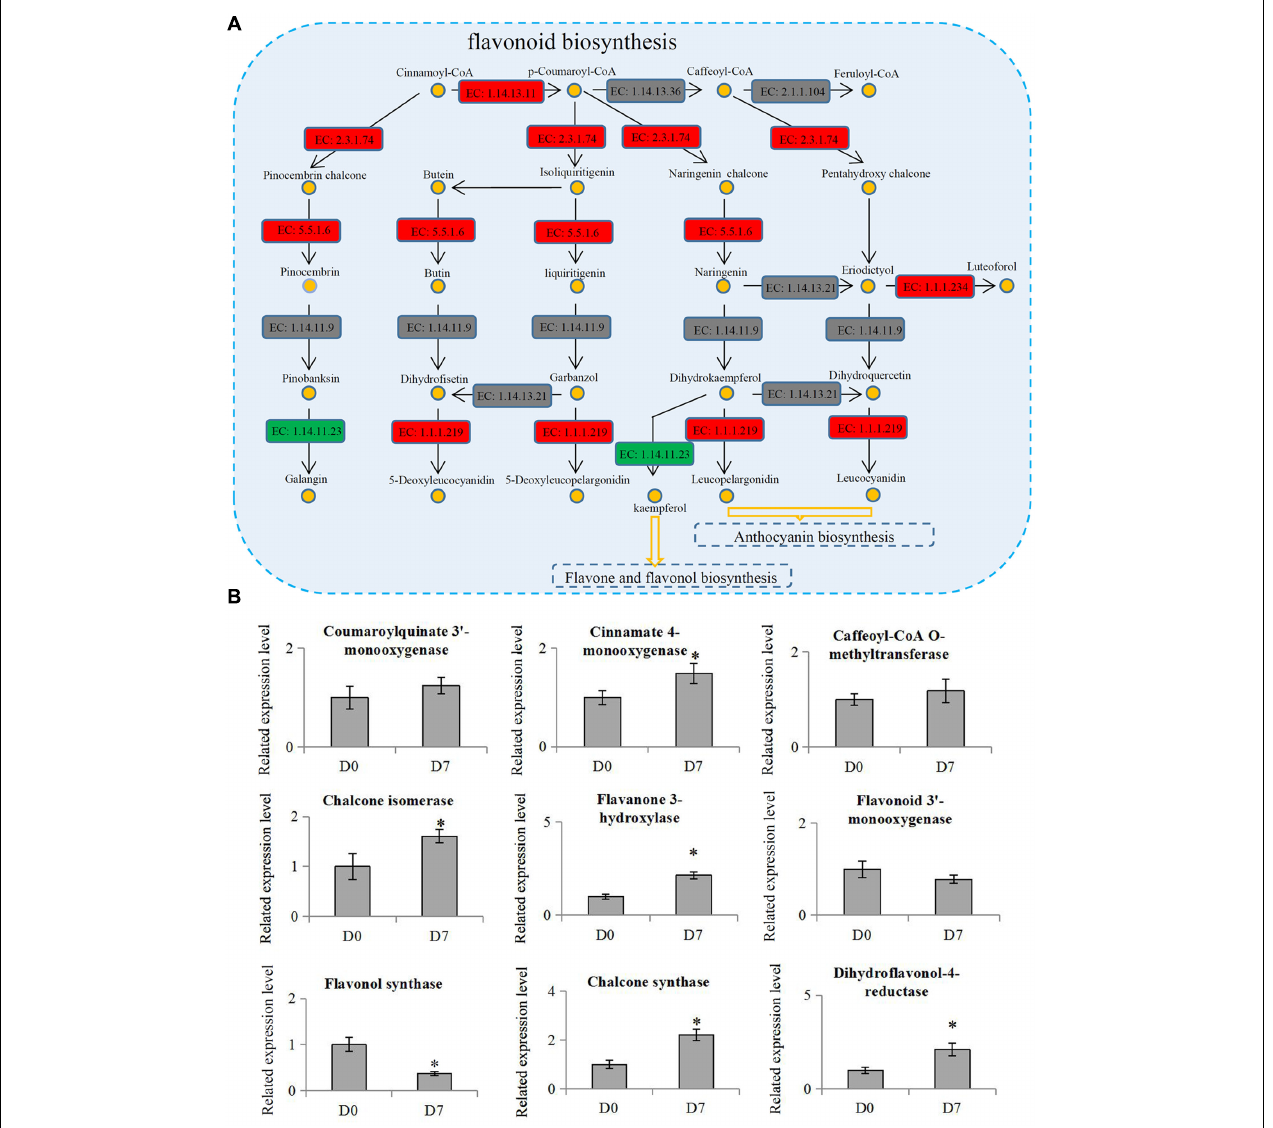
FIGURE 5 | Involvement of flavonoid biosynthesis in the grafting process in hickory. (A) Schematic representation of the proteins involved in flavonoid biosynthesis pathway. ‘EC: 1.14.13.11’: trans-cinnamate 4-monooxygenase; ‘EC 1.14.13.36’: 5- O -(4-coumaroyl)- D -quinate 3 (cid:48) -monooxygenase; ‘EC: 2.1.1.104’: caffeoyl-CoA 3- O -methyltransferase; ‘EC: 2.3.1.74’: naringenin-chalcone synthase; ‘EC: 5.5.1.6’: chalcone isomerase; ‘EC: 1.14.11.9’: flavanone 3-dioxygenase; ‘EC: 1.14.13.21’: flavonoid 3 (cid:48) -monooxygenase; ‘EC: 1.1.1.234’: flavanone 4-reductase; ‘EC: 1.14.11.23’: flavonol synthase; ‘EC: 1.1.1.219’: dihydrokaempferol 4-reductase. Red indicates up-regulation proteins, green indicates down-regulation proteins and gray indicates un-identified proteins. (B) Relative expression levels of flavonoid biosynthesis related proteins in hickory. Significant differences in expression level were indicated by “ ∗